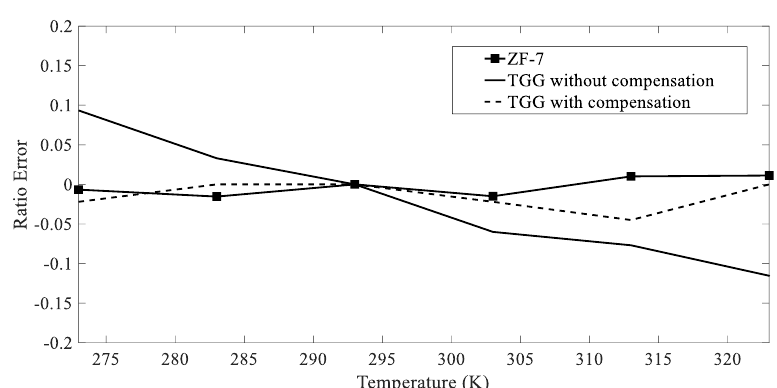
Figure 10. E ff ect of temperature on measurement error of magneto-optical materials.